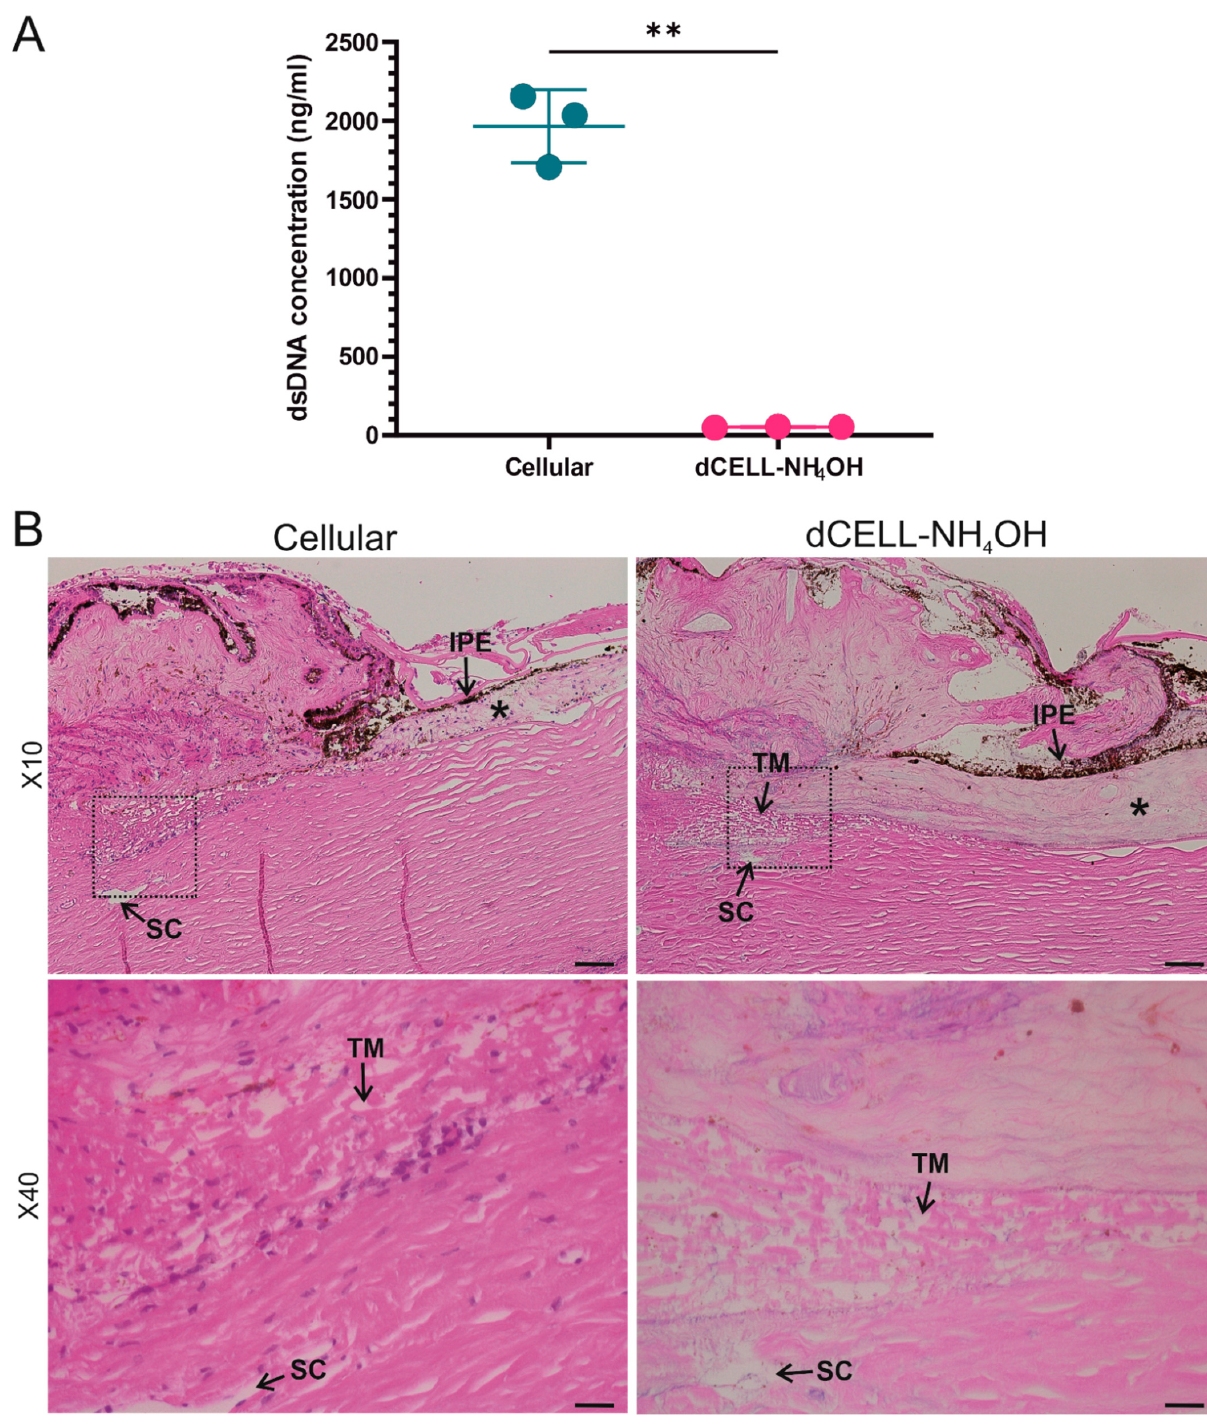
Figure 4. ( A ) Comparison of double-strand DNA concentration in cellular and decellularized human trabecular meshwork using Ammonium Hydroxide (NH 4 OH, 2%, 2 h). Paired t -test (n = 3), significance for p < 0.05, ** represents p < 0.01. ( B ) Representative H&E-stained images of cellular and dCELL–NH 4 OH human trabecular meshwork. Trabecular meshwork (TM) and Schlemm’s canal (SC) located by black arrows. * indicates the iris. Dashed black box in x10 magnification images indicate region of interest for x40 magnification images. Pigmentation in tissue structure is the iris pigmented epithelium (IPE), located by black arrows. Scale bars = 50 µm (x10) and 20 µm (x40).